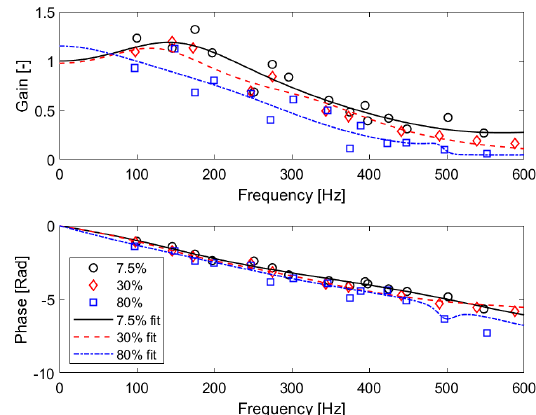
Figure 11. Predicted FDF or non-linear flame transfer function.